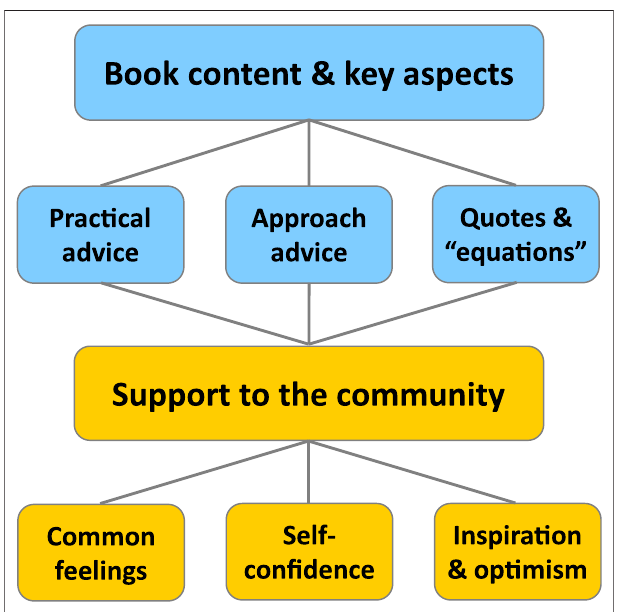
FIGURE 1 | Key content aspects of the book (blue boxes) and main messages helpful for the academic community (yellow